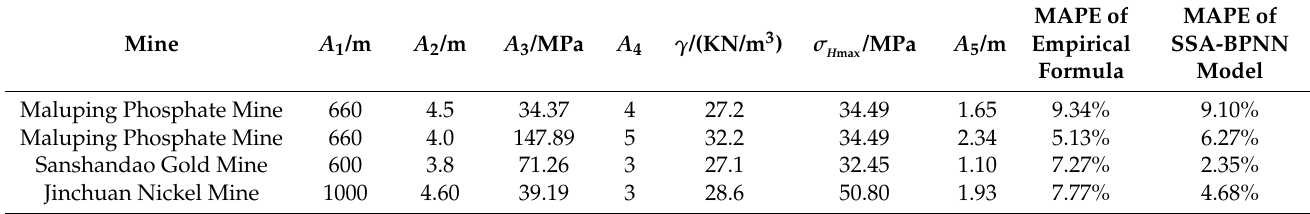
Table 6. Predictive performance of SSA-BPNN model and empirical